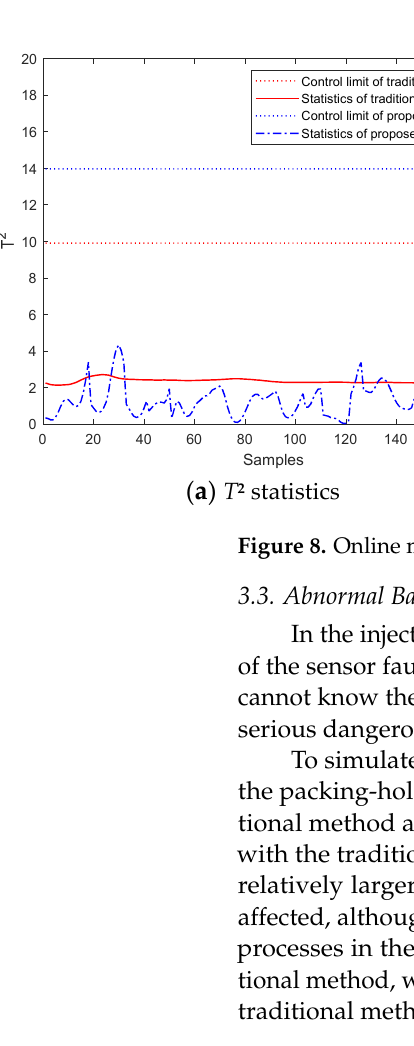
Figure 7. Online monitoring of the plasticizing phase.